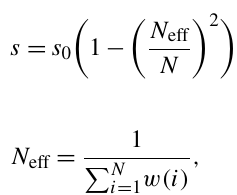
assimilation Eq. (17)